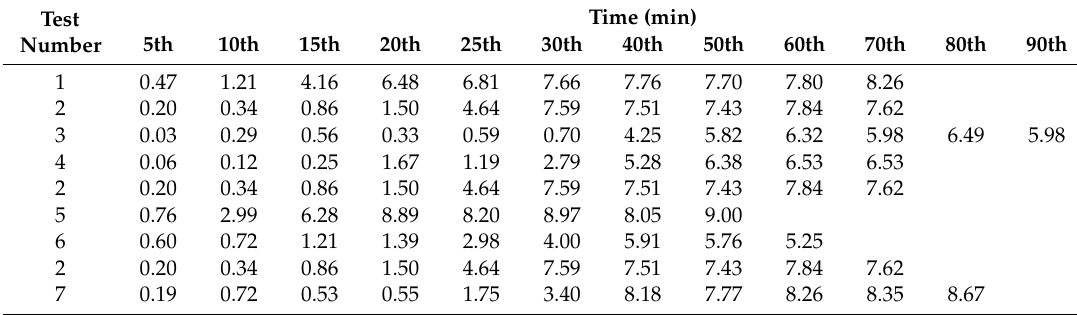
Table 3. Variation of water-outflow rate with time (m 3 / h).